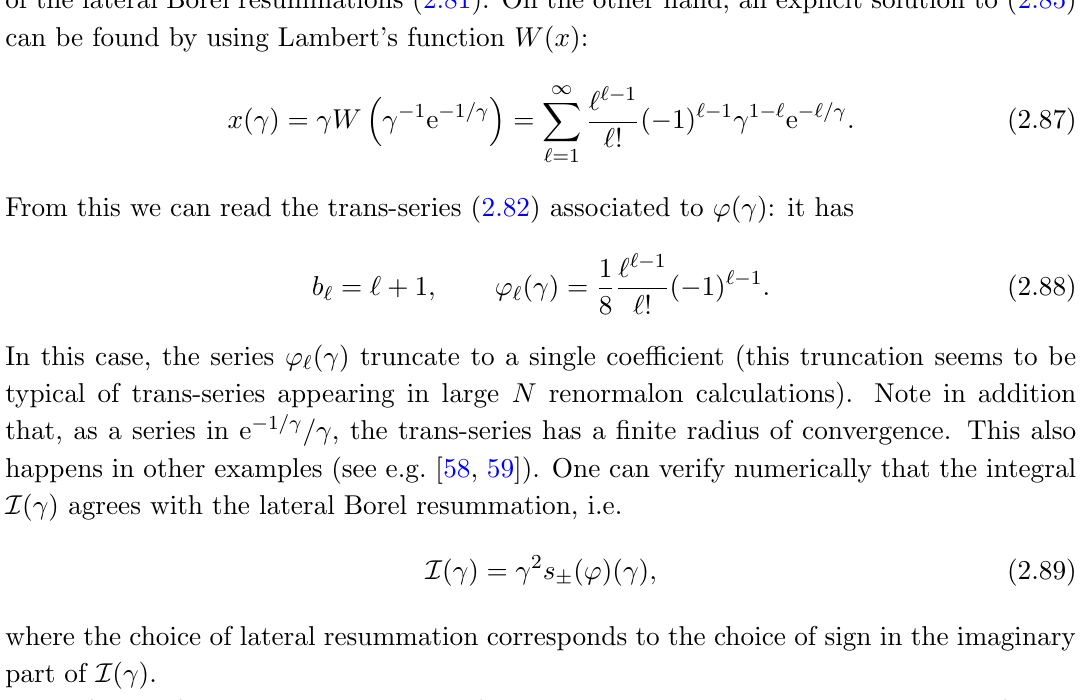
. (cid:1) (cid:1) (cid:1) 12 (cid:25)‘= ( N b g )) in the (cid:0)